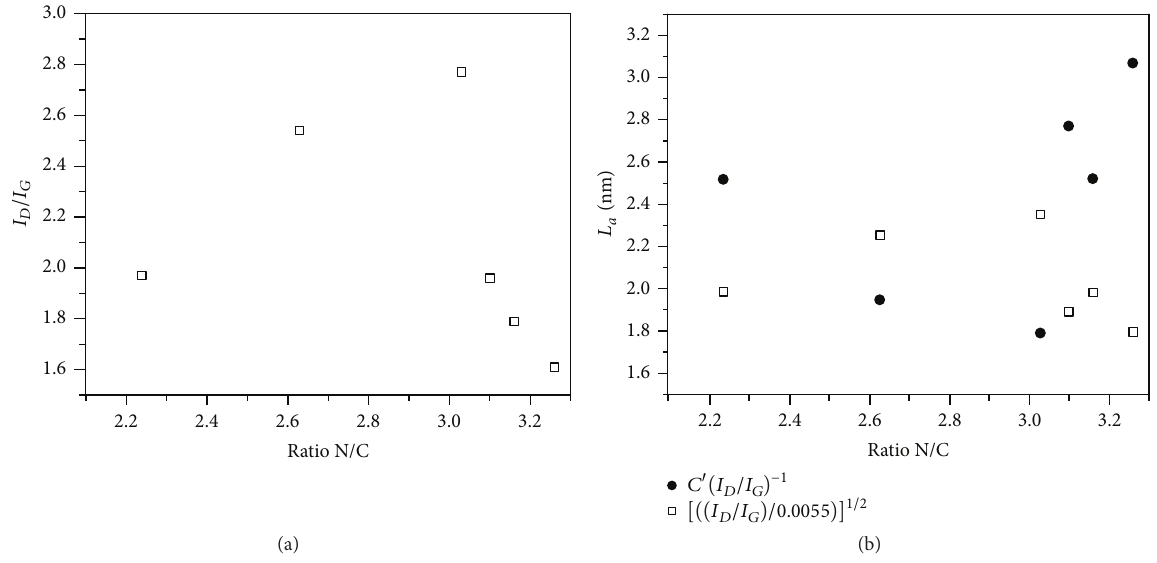
Figure 4: Changes in 𝐼 𝐷 /𝐼 𝐺 versus the N/C ratio (a). Variation of 𝐿 𝑎 , obtained from the Tuinstra-Koenig and Ferrari-Robertson models versus the N/C